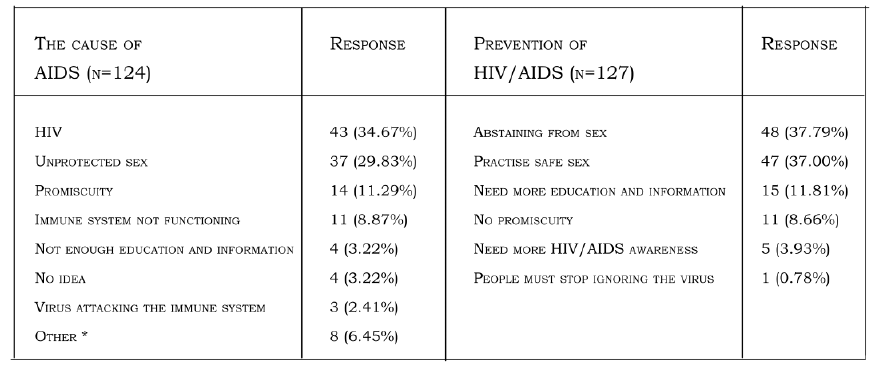
Table 6: Responses to open-ended